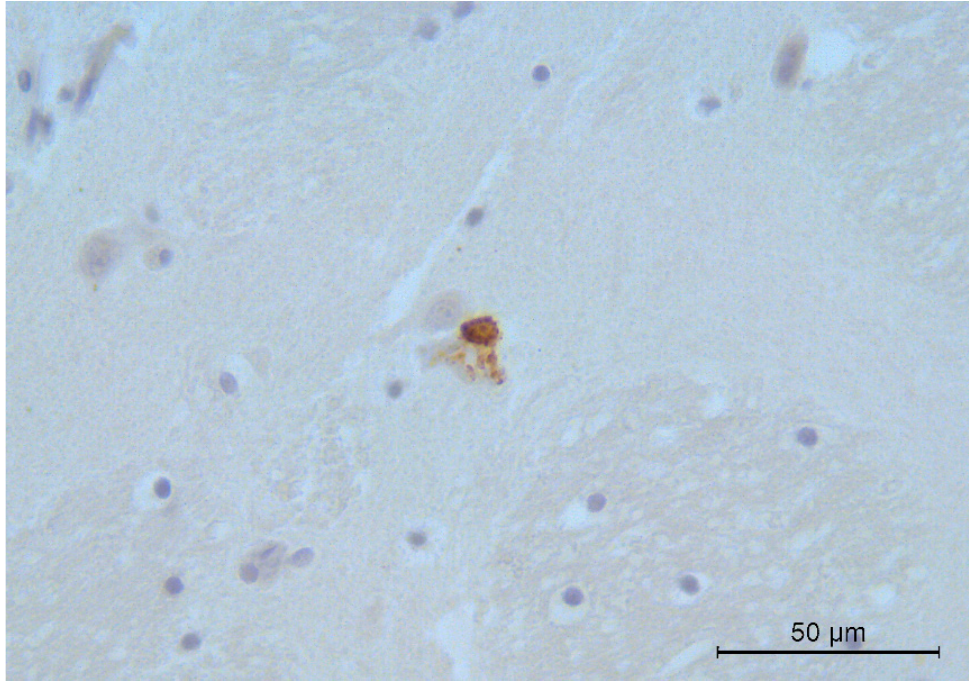
Figure 1. Fox. Brain. Intense CDV immunoreactivity in a cerebral cortex neuron. Immunohistochemistry, 400× magnification.